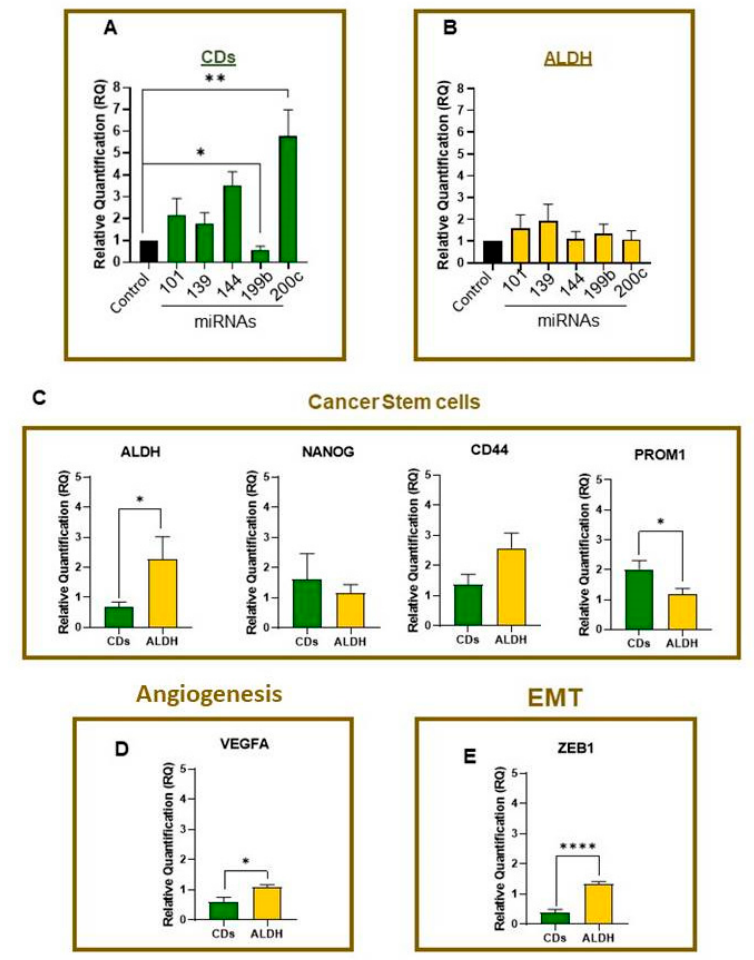
Figure 6. ( A ) CD44/CD117/CD133 triple-positive cell overexpresses miR-200c-3p compared with triple-negative cells ( t -test **, p = 0.004) and downregulates miR-199b-5p ( t -test *, p = 0.03). ( B ) We observed no difference between ALDH+ and ALDH- populations for all miRNAs ( p < 0.05). ( C ) Cancer stem cell-related gene expression in the ALDH+ cells (Mann–Whitney test *, p = 0.02) was not statistically significant for NANOG (Mann–Whitney test ns, p > 0.05) and CD44 ( t -test ns, p > 0.05), and CD44/CD117/CD133 triple-positive cells showed an augmented expression of PROM1 ( t -test *, p = 0.03). The mRNA expression of the angiogenesis and EMT genes: ( D , E ) VEGF-A and ZEB1 increased in ALDH+ cells ( t -test *, p = 0.02 and ****, p < 0.0001, respectively).